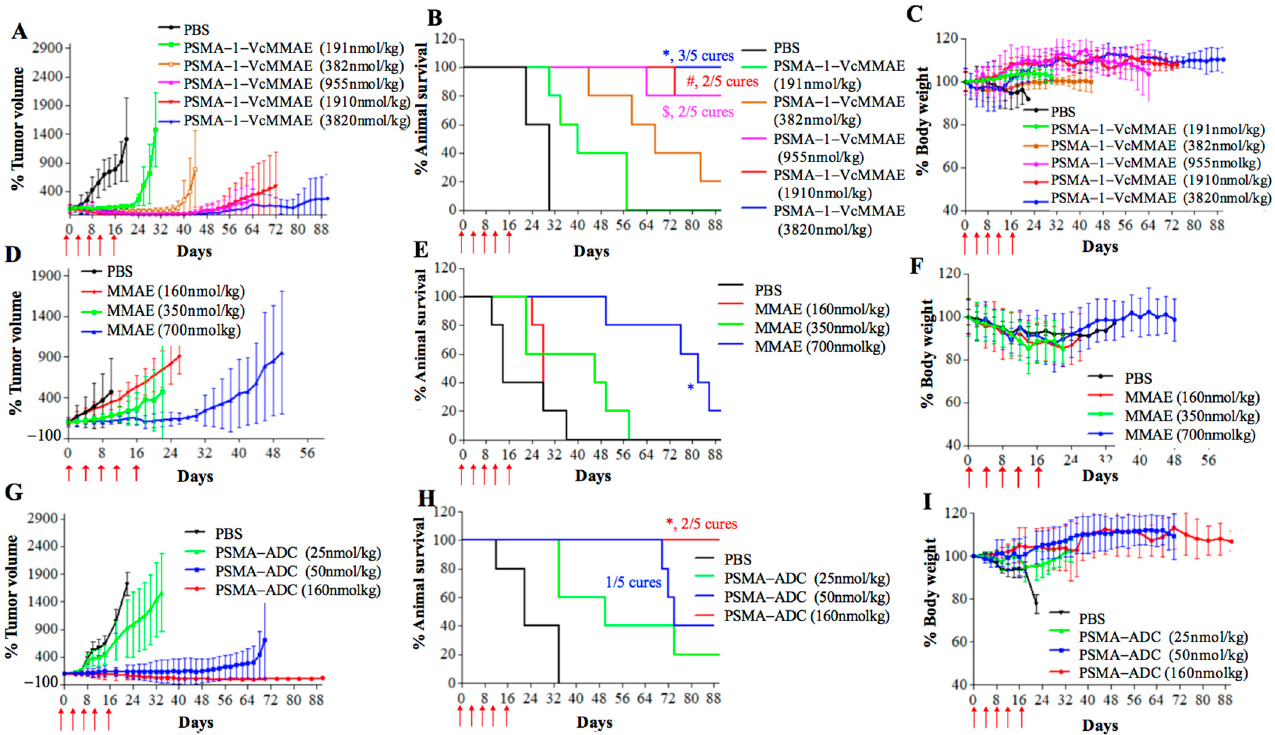
Figure 8. Dose response of antitumor activity in mice bearing heterotopic PC3pip tumors. Mice received drug through tail vein injection. Treatment were scheduled every 4 days with a total of five doses as indicated by the red arrow. Each group had five mice. For tumor growth curves and body weight curves, values are mean ± SD of five animals. The plots stopped when animals died during the experiments since values are represent as mean ± SD of five animals. ( A ) Tumor growth curves of mice treated with PSMA-1-VcMMAE. ( B ) Kaplan–Meier survival curves of mice treated with PSMA-1-VcMMAE. ($, 955 nmol/kg vs. PBS, p = 0.0046; #, 1910 nmol/kg vs. PBS, p = 0.0004; *, 3820 nmol/kg vs. PBS, p = 0.0004). ( C ) Body weight changes of mice treated with PSMA-1-VcMMAE. ( D ) Tumor growth curves of mice treated with MMAE. ( E ) Kaplan–Meier survival curves of mice treated with MMAE. (*, 700 nmol/kg vs. PBS, p = 0.0005). ( F ) Body weight changes of mice treated with PSMA-1-VcMMAE. ( G ) Tumor growth curves of mice treated with PSMA-ADC. ( H ) Kaplan–Meier survival curves of mice treated with PSMA-ADC. (*, 160 nmol/kg vs. PBS, p = 0.0002). ( I ) Body weight changes of mice treated with PSMA-ADC.